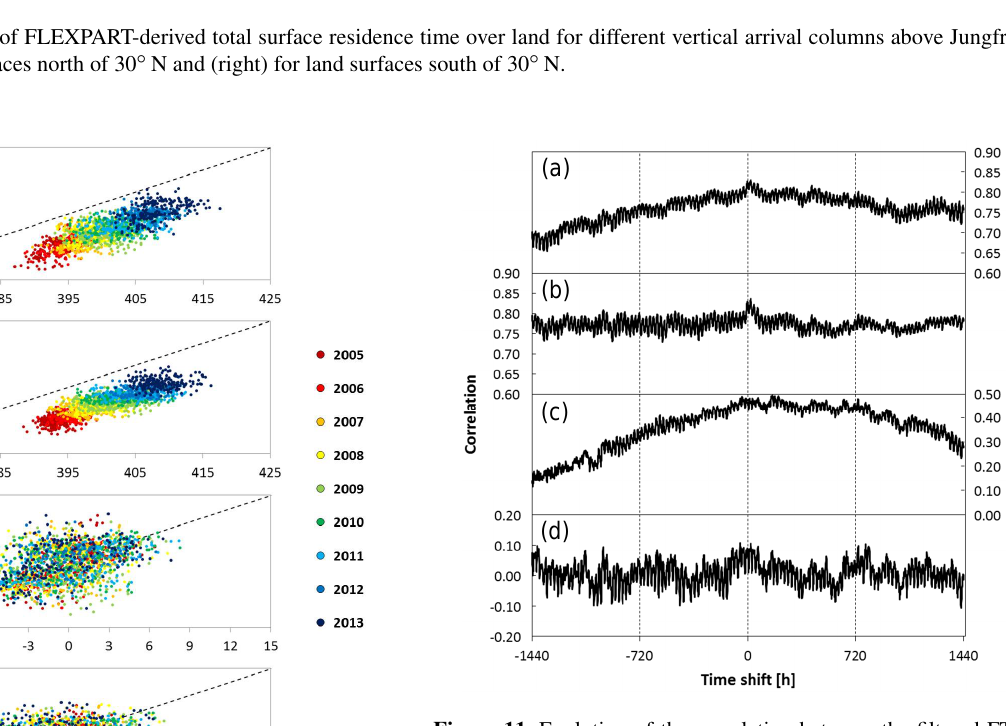
Figure 11. Evolution of the correlation between the filtered FTIR and NDIR data sets with changing time shift. (a) Correlation be- tween complete data sets; (b) correlation between the two data sets without seasonality; (c) correlation between the two data sets with- out trend; (d) correlation between the two data sets with neither trend nor